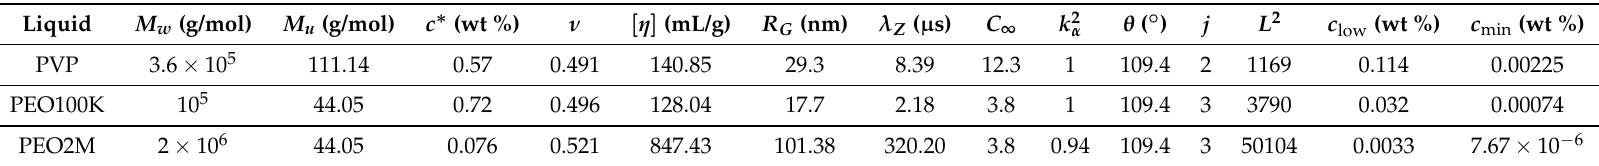
Table 1. Properties of the three polymeric solutions analyzed in this paper: molecular weight M w , molar mass of the monomer M u , overlap concentration c ∗ , solvent quality exponent ν , intrinsic viscosity [ η ] [23,27,28], gyration radius R G [27–29], longest Zimm relaxation time λ Z , characteristic ratio C ∞ [30], swelling ratio k [12], C-C bond angle of the monomer θ [30,31], number of bonds of the monomer j [30,31], finite extensibility parameter L 2 [19], concentration c low above a true elasto-capillary regime appears [12], and minimum concentration c min to observe an elastic contribution during the breakup